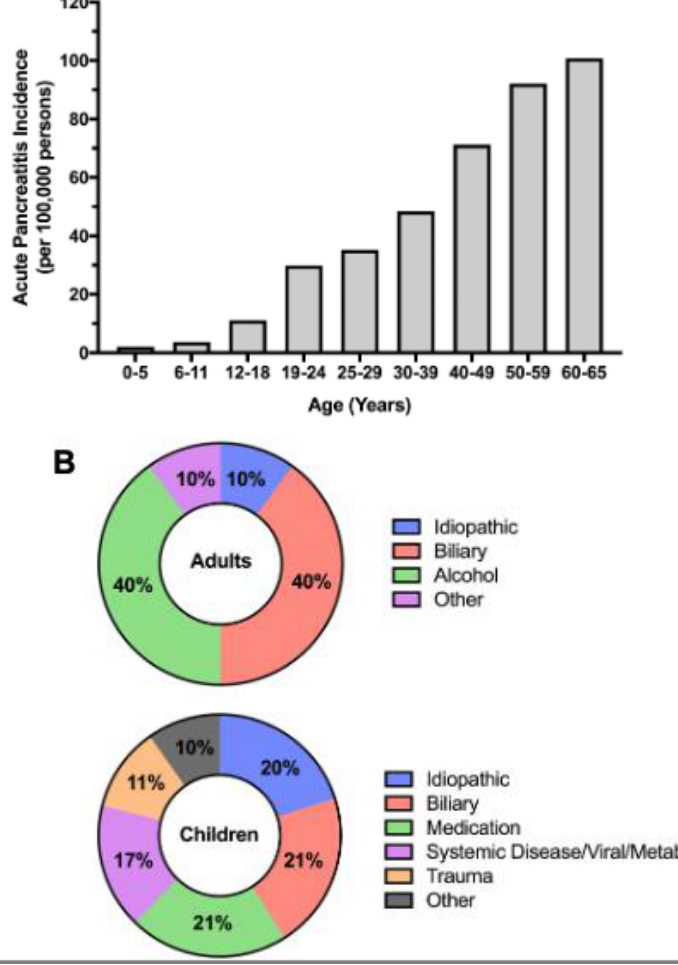
Figure 1. Comparison of the epidemiology and etiologies of pediatric and adult acute pancreatitis (AP). ( A ) Incidence of AP across age groups in 2014 in the United States from the Truven Health MarketScan Commercial Claims and Encounters database. Data represent a composite of both inpatient and outpatient encounters. Adapted from Sellers et al. [7] ( B ) Relative comparison of the differing contributing factors to pediatric and adult AP. Adapted from Abu-El-Haija et al. [10,11] and Husain et al.